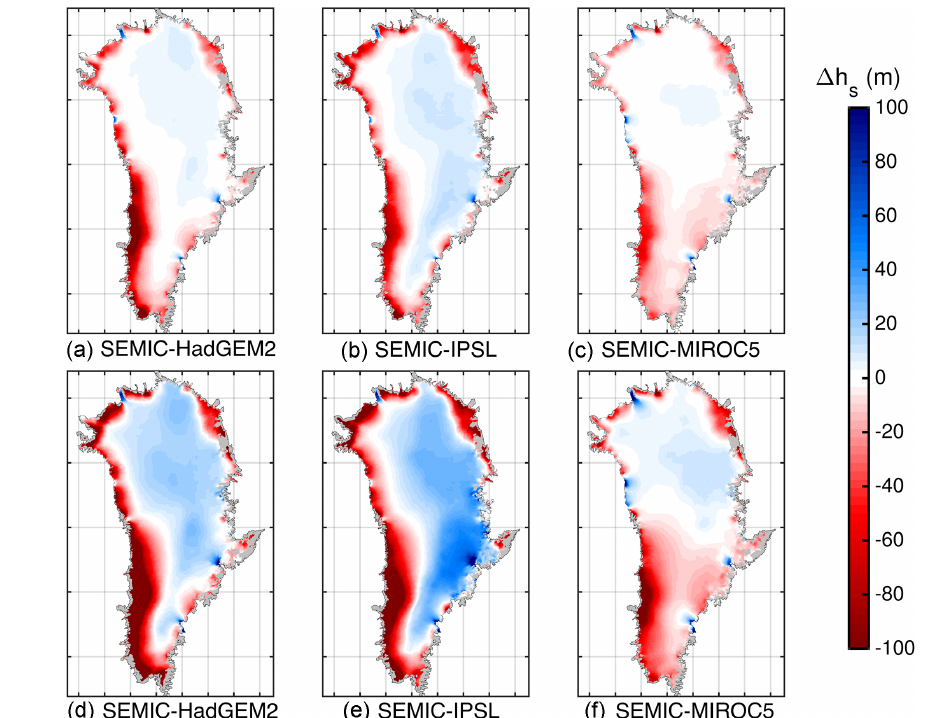
Figure 13. Comparison of multi-year mean surface elevation ( h s ) differences under RCP2.6 forcing between 2100–2000 (a–c) and 2300– 2000 (d–f) for (a, d) SEMIC-HadGEM2, (b, e) SEMIC-IPSL, and (c, f) SEMIC-MIROC5. The black contour line depicts the present-day ice mask. Positive values represent glacier thinning, and negative values thickening. The data are clipped at an ice thickness of 10m (gray shaded